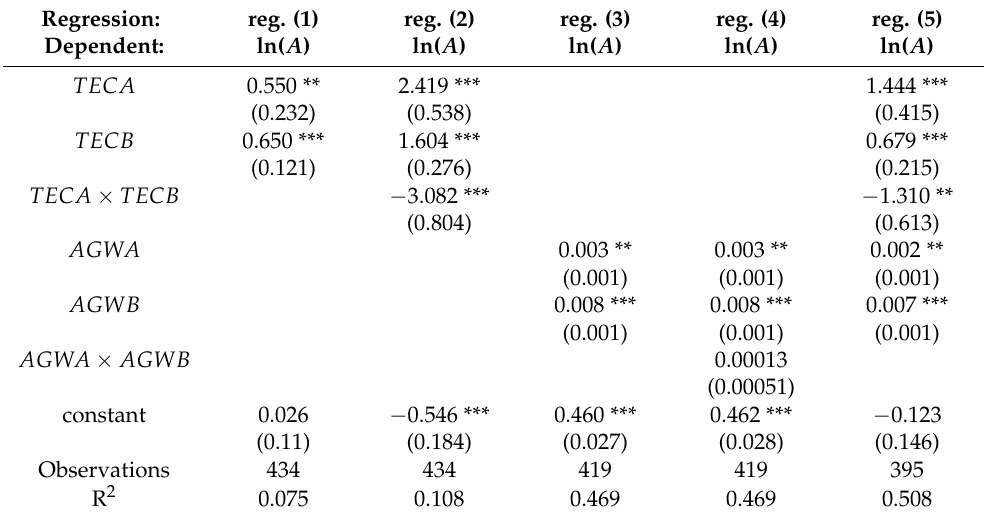
Table 4. Determinants of the ATP